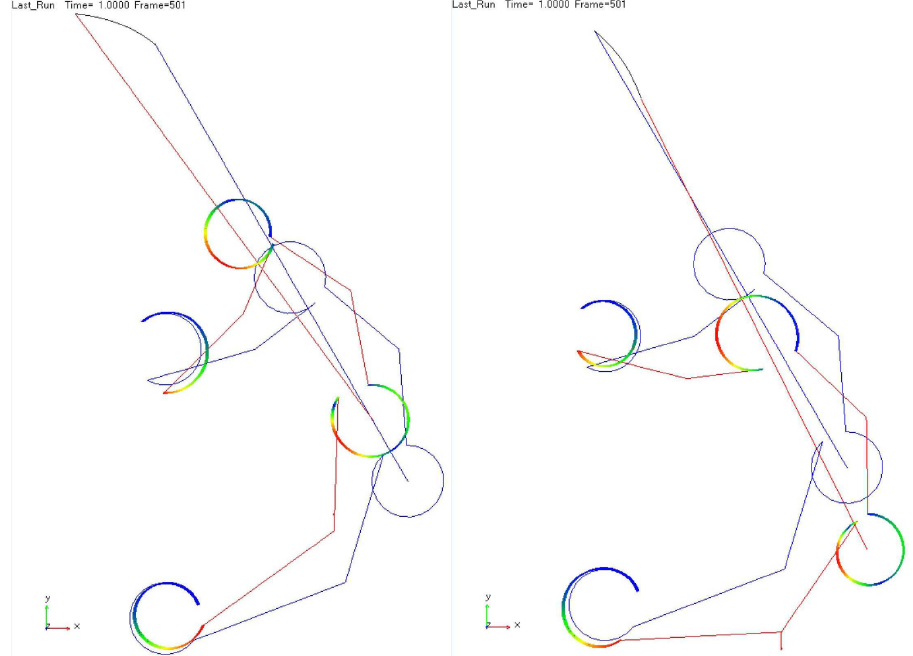
Figure 8. Adams results: ( left ) forward movement; ( right ) backward movement. The deformed gripper is in red, while the undeformed configuration is represented in blue color. The trajectory of the end-effector for the two movements is displayed in black